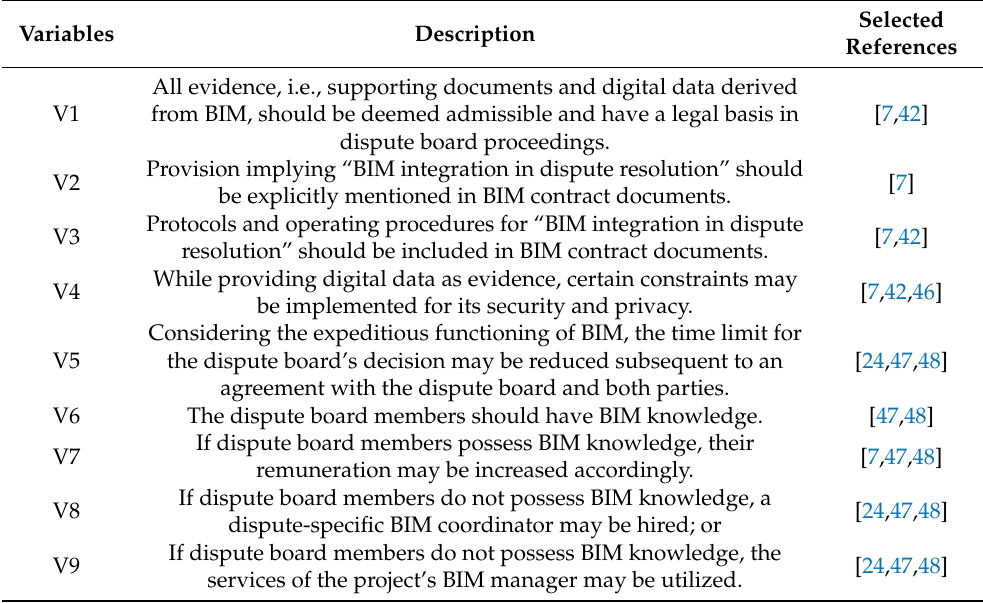
Table 1. Potential legal aspects/contract provisions for contract structure and